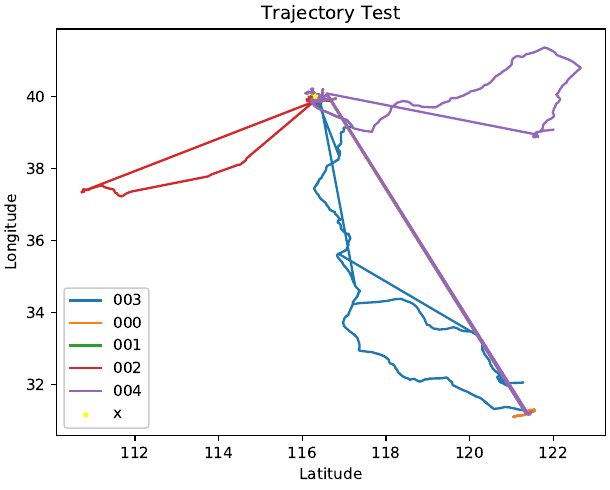
Figure 3. Trajectories of users [000, 001, 002, 003, 004] and point (40.01, 116.31). The calculated 2-dimensional kernel density and time-space density at (40.01, 116.31) were 2.75 and 2.77 respectively, which are very similar.